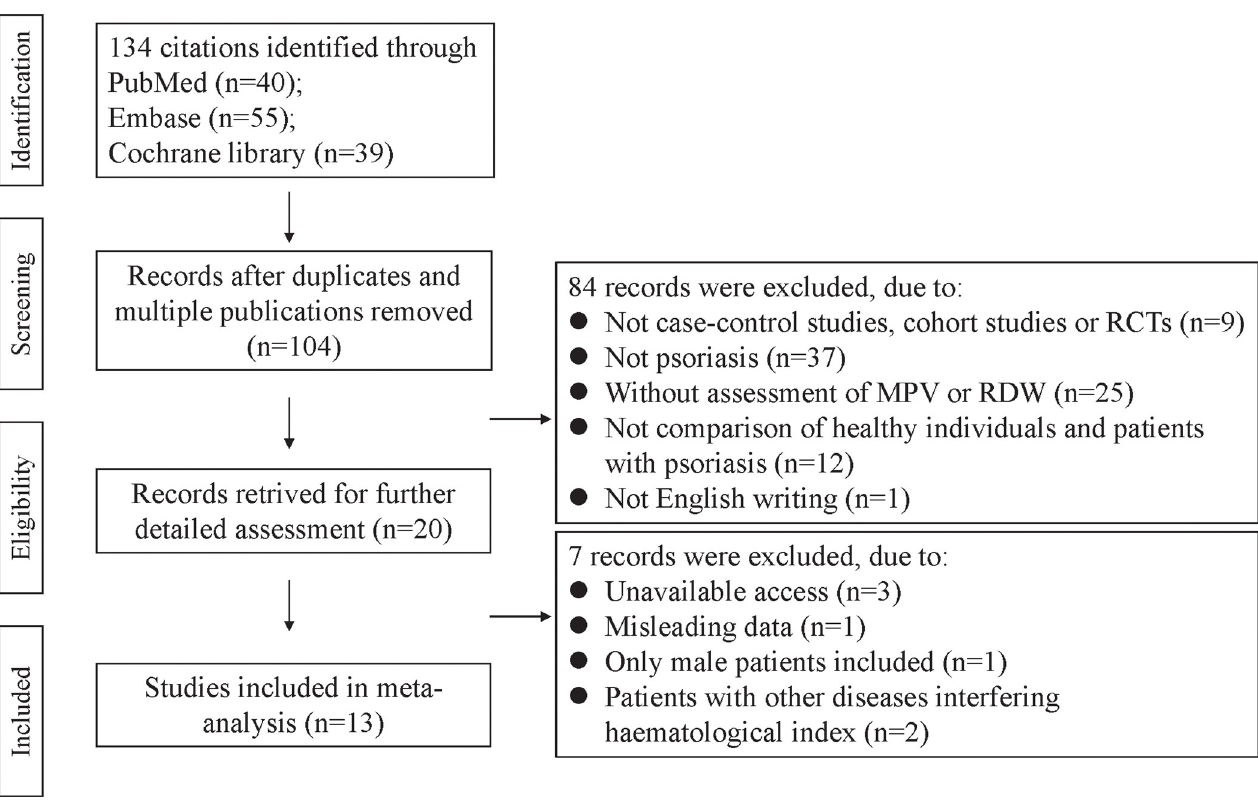
Fig 1. Flowchart of literature screening in the meta-analysis.